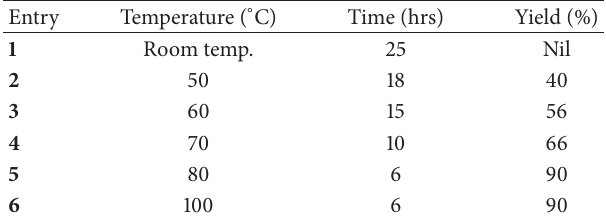
Table2:Effectoftemperatureontheformationof 5a inthepresence of alum as catalyst.